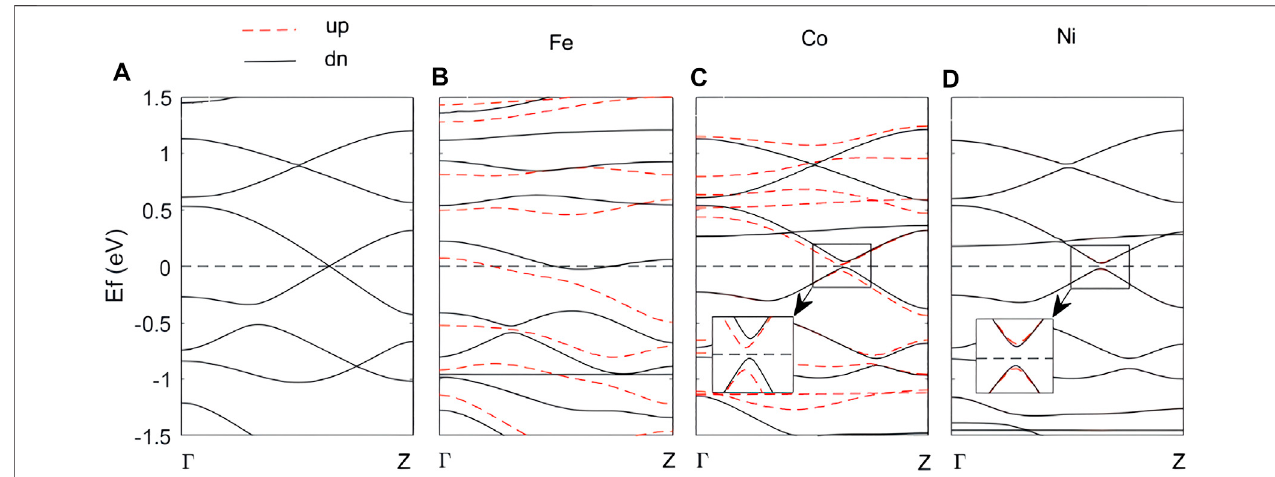
FIGURE 2 | The band structure of the original N-ZGyNR (A) and that of the M-N-ZGyNR (M = Fe, Co or Ni) when the spin direction of the doped atom M is set to spin-up (B – D) .Thebandstructureofspin-up(spin-down)electronsisrepresentedbyreddottedlines(blackreallines).TheFermilevelissettozero,whichisrepresented by the horizontal dotted